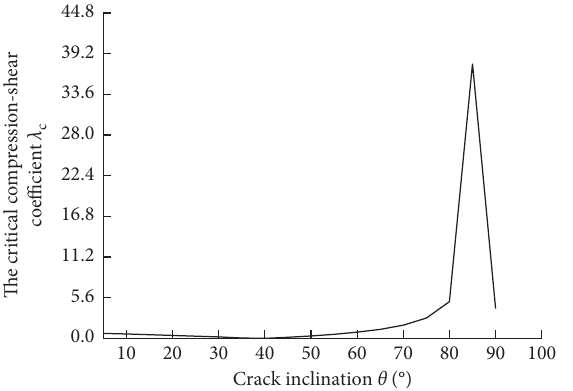
Figure 13: Relationship between critical compression-shear co- efficient and crack inclination of closed crack.